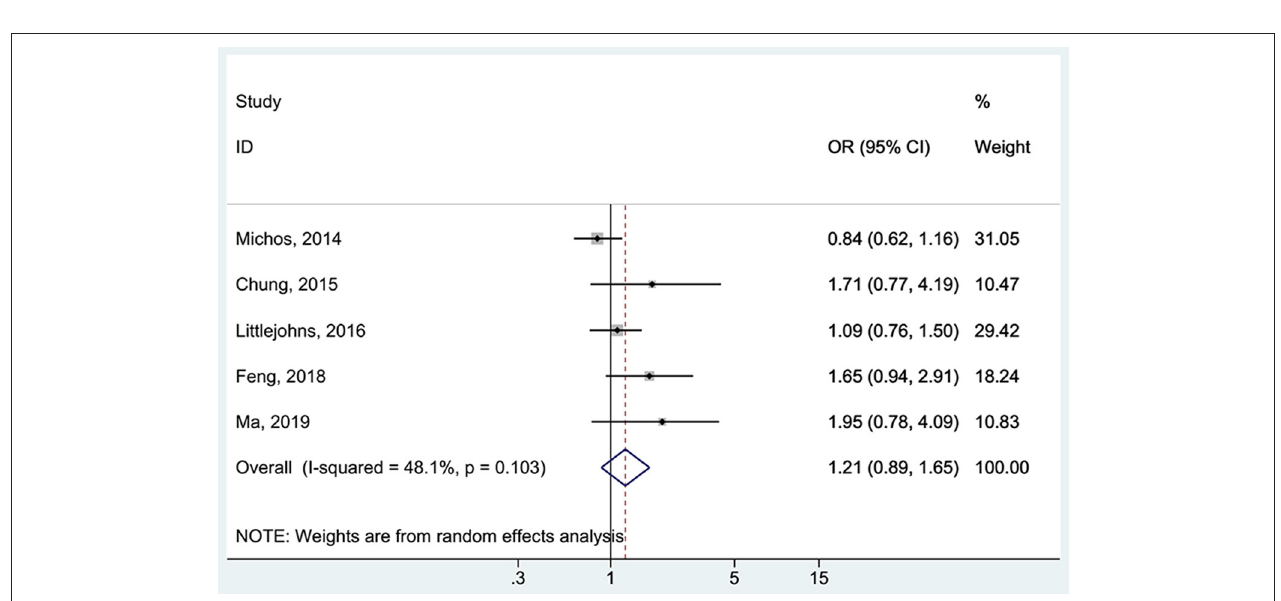
FIGURE 2 | Forest plot of deficient vs. sufficient vitamin D level. % Weight represents the contribution of the sample size of each study to the total number of patients included in the analysis.